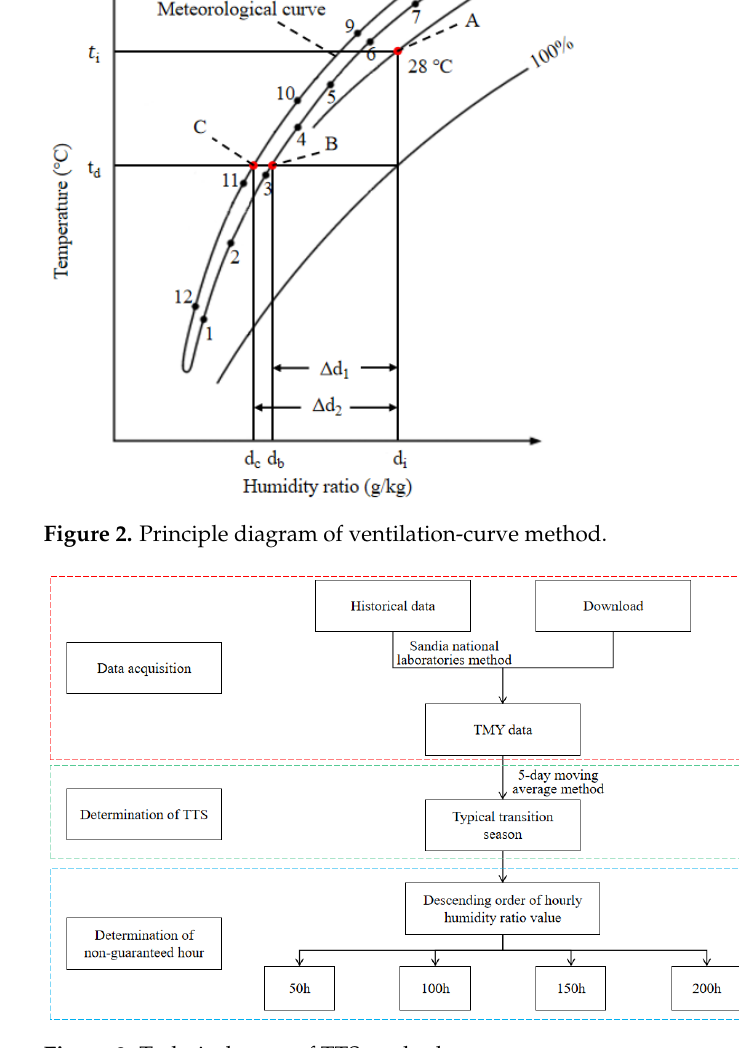
Figure 2. Principle diagram of ventilation-curve method.